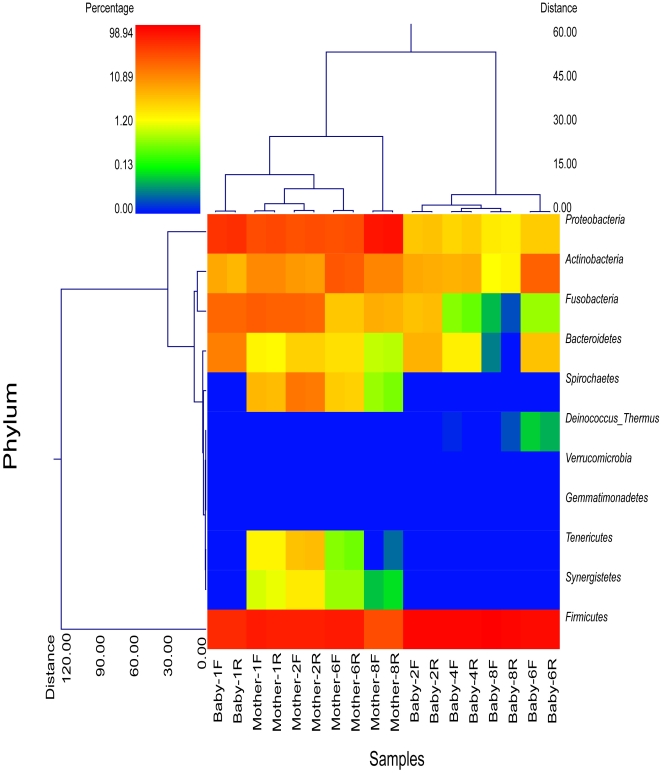
Dual hierarchical clustering dendogram of the bacterial phyla profiles for babies and mothers.Baby and mother number and sequence direction [forward (F); reverse(R)] are provided on the bottom x-axis. The dendogram provides the phylum designation along the right y-axis and the abundance relationship across all samples for each phylum based upon Wards clustering and Manhattan distance methods along the left y-axis. The relative distance scale for the left y-axis is provided in the lower left corner of the figure. The samples have also been clustered based upon Wards and Manhattan principles with sample designations along the bottom x-axis and the clustering described along the top x-axis in the figure. The heatmap depicts the relative percentage of each phyla for each sample. The color scale for the heatmap is shown in the upper left corner of the figure. It is obvious from the figure that the microbiome of the mothers and babies are clearly separable but forward and reverse reads cluster together.